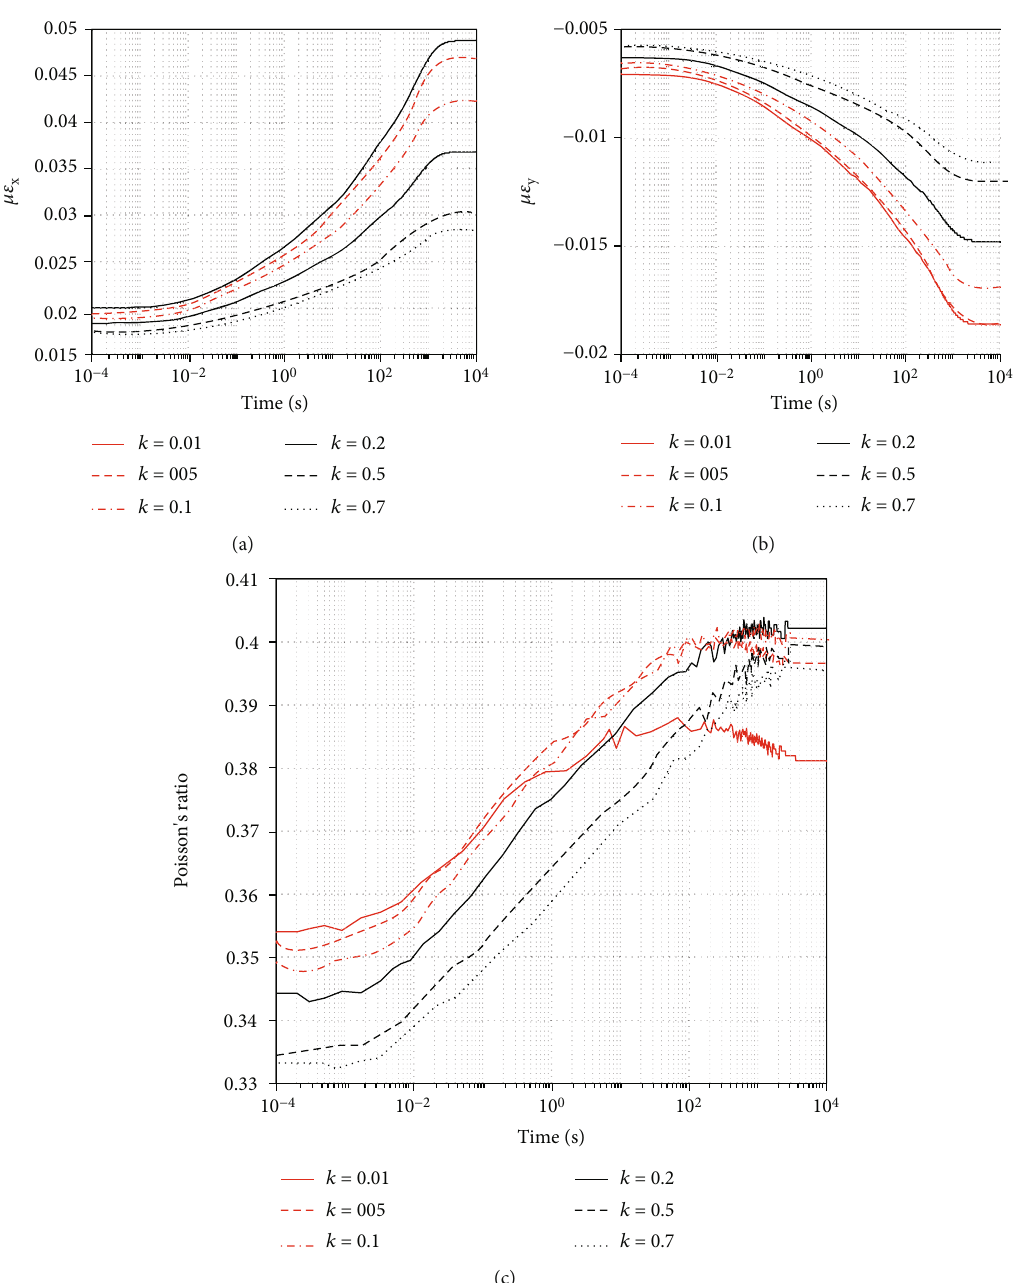
Figure 11: The curves of the (a) longitudinal strain, (b) transverse strain, and (c) Poisson ’ s ratio versus time under di ff erent transition